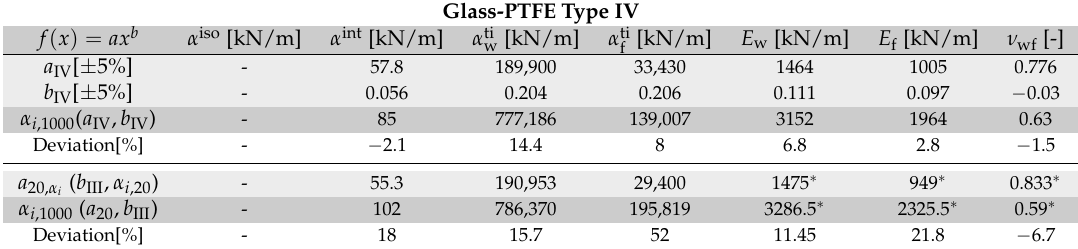
Table 8. Extrapolated material parameters and the computed coefficients of the estimation function using glass-PTFE IV data. Deviation is computed as relative difference of an estimated parameter from its original value in Tables 4 and